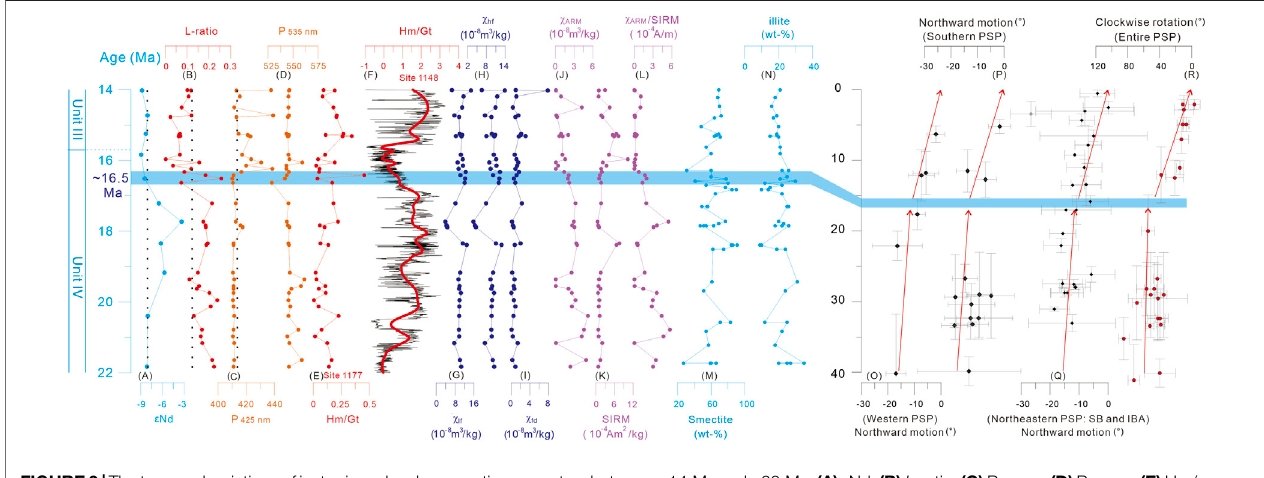
FIGURE3| Thetemporalvariationsofisotopicandrock-magneticparametersbetween~14 Maand~22 Ma: (A) ε Nd, (B) L -ratio, (C) P 425 nm , (D) P 535 nm , (E) Hm/ Gt of Site 1177, (F) Hm/Gt of Site 1148 (Clift et al., 2014), (G) χ lf , (H) χ hf , (I) χ fd , (J) χ ARM , (K) SIRM, (L) χ ARM /SIRM, (M) smectite, and (N) illite (Steurer and Underwood, 2003; Underwood and Fergusson, 2005). The northward motion of (O) the western PSP (Queano et al., 2007), (P) the southern PSP (Hall et al., 1995), (Q) the northeastern PSP (DSDP and ODP sites in the SB and IBA: sites 442, 782, 784, 786, 787, 792, 793, and 1177) (Kinoshita, 1980; Haston and Fuller, 1991; Haston et al., 1992; Liu et al., 2021), and (R) the clockwise rotation of the PSP (Haston and Fuller, 1991; Queano et al., 2007). The blue thick lines mark the sudden changes in geochemical, rock-magnetic, and spectral parameters, and tectonic movement of the PSP. The red lines in (O – R) are used to visualize the tectonic movement trends.